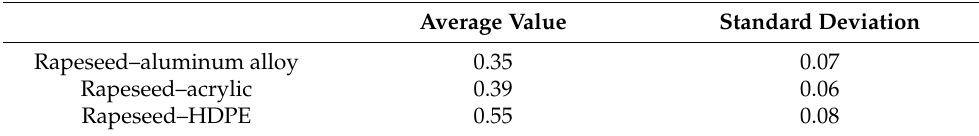
Figure 2. The metering device for measuring bouncing height between rapeseed and the contact materials. Table 3. Coefficient of restitution values between rapeseed and the contact materials.